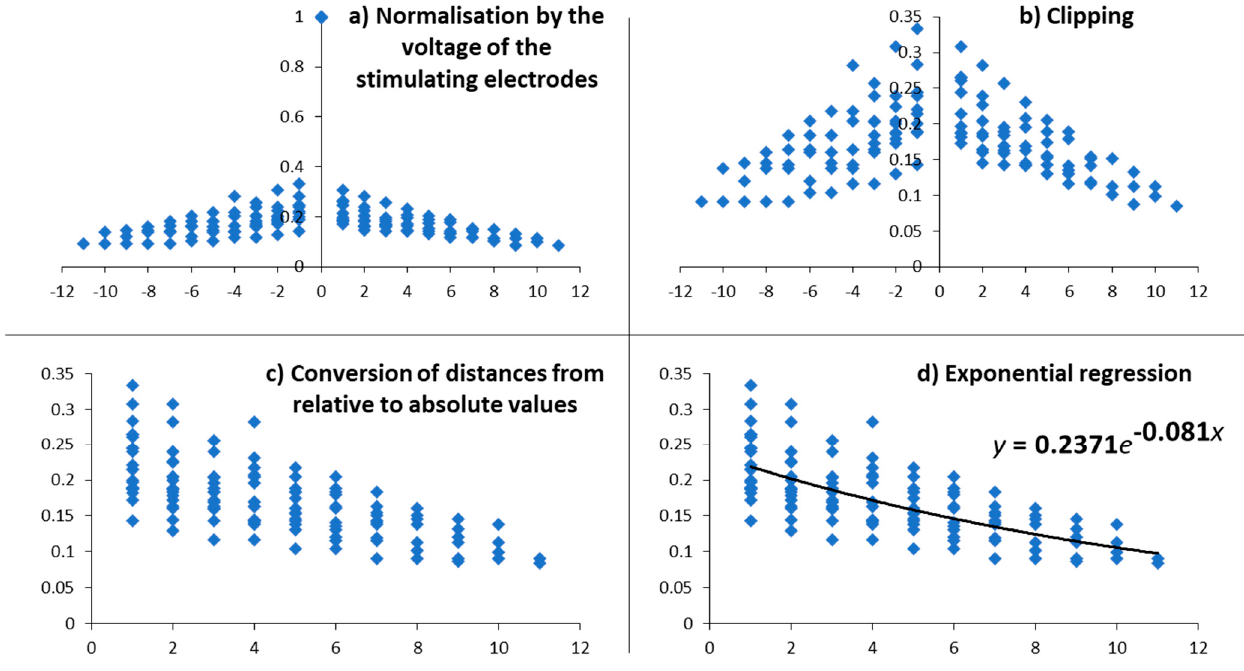
Figure 3. Example of the data processing performed for the voltages measured in the subject S35. The normalised voltages are expressed in arbitrary unit, the distance between the stimulating and the recording electrode is expressed in number of electrodes. ( a ) For each stimulating electrode, the voltages of all active electrodes are normalised according to the voltage measured at the level of the stimulating one. ( b ) The normalised voltages of the stimulating electrodes (all equal to 1) are removed from the data. ( c ) As we consider here the current spread to be symmetrical, the relative distances are converted in absolute values. ( d ) An exponential regression was computed to determine an exponential spread coefficient (ESC, in exponent) reflecting the decrease in current as the distance from the stimulation increases. We use this coefficient as a measure of the current spread with the assumption that a broader spread will result in a lower voltage decrease with distance and thus a higher coefficient (close to 0), and conversely, a narrower spread will result in a lower